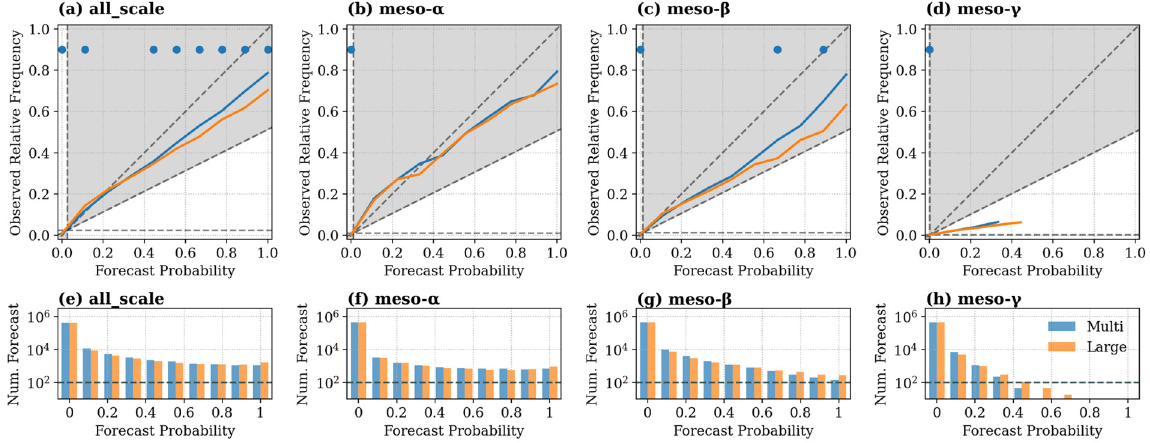
Figure 12. ( a – d ) Reliability diagrams and ( e – h ) associated sharpness diagrams for the full field, meso-alpha, meso-beta, and meso-gamma subfields, respectively, accumulated over 1–6h forecasts of 25 cases. Dots (triangles) indicate statistically significant differences between MULTI and LARGE at the 10% (20%) confidence level determined by the Wilcoxon rank sum test. The dashed line in each sharpness diagram indicates the minimum sample size (100) used for presenting reliability diagram values.